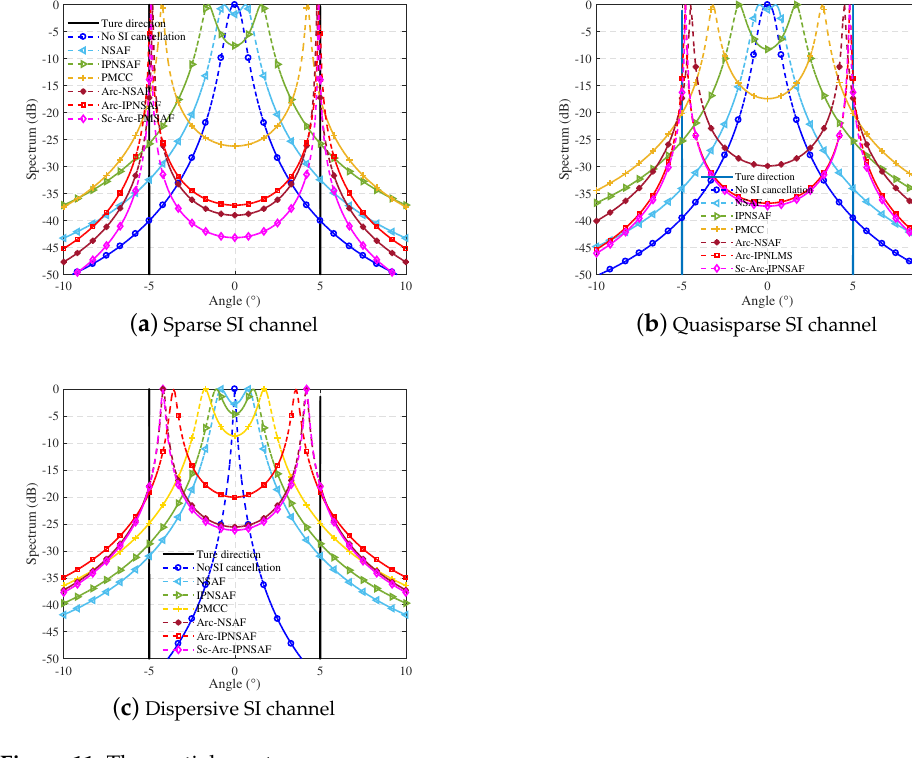
Figure 11. The spatial